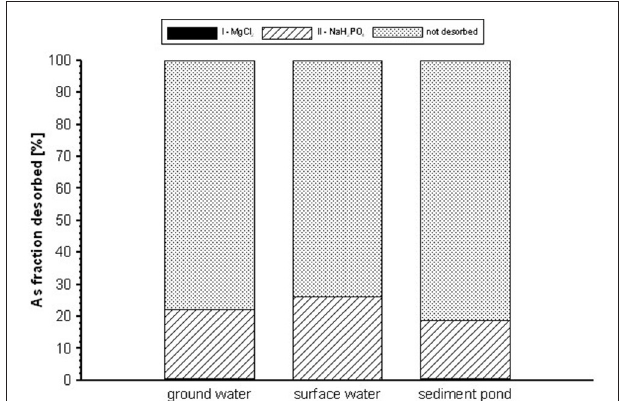
FIGURE 9 | Desorption of As from the